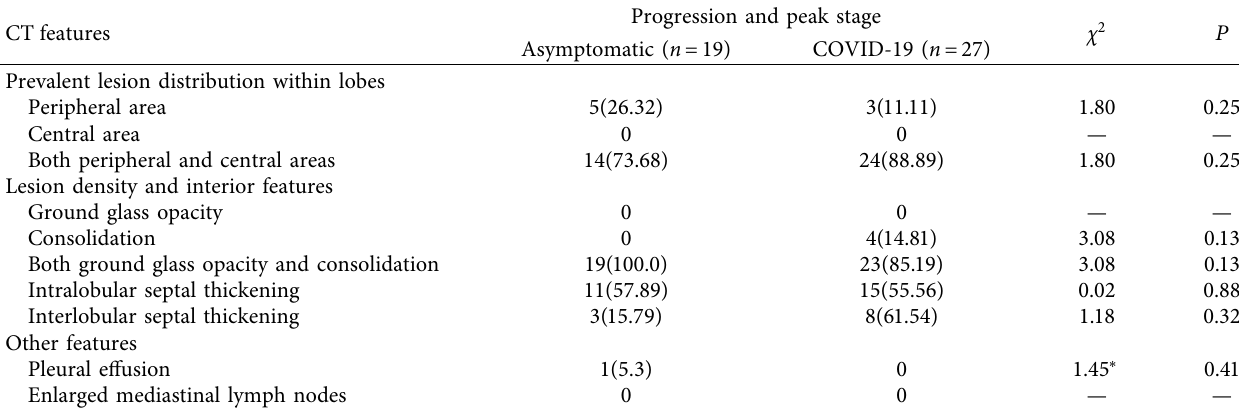
Table 4: Imaging of asymptomatic carriers and COVID-19 patients in the progression stages [ n